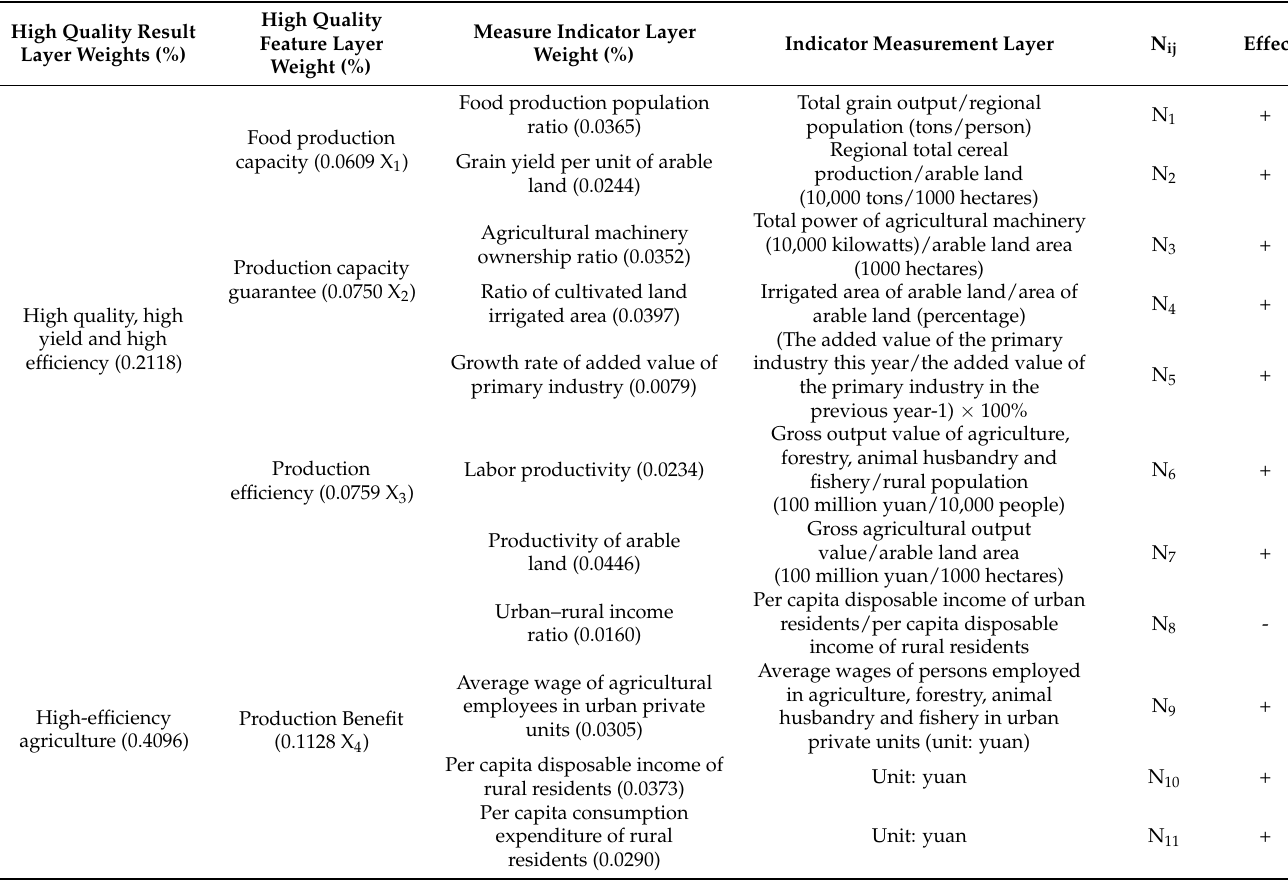
Table 3. Agricultural high-quality development level measurement